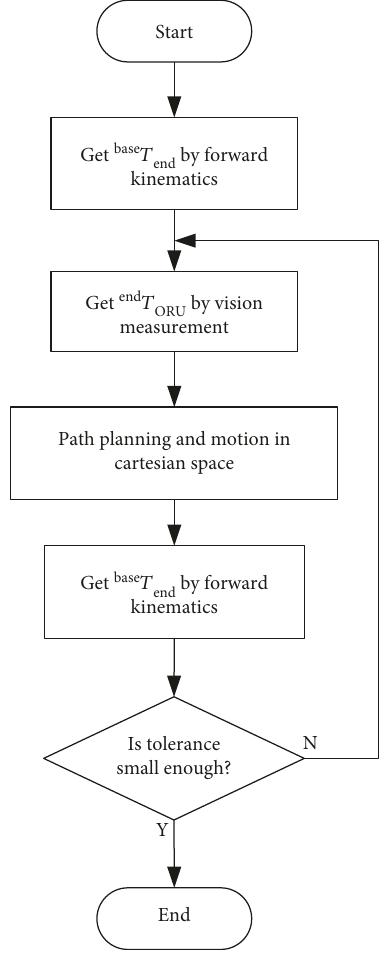
Figure 12: Closed loop path planning algorithm fl Figure 13. Here, Gaussian fi lter is used for denoising. A local